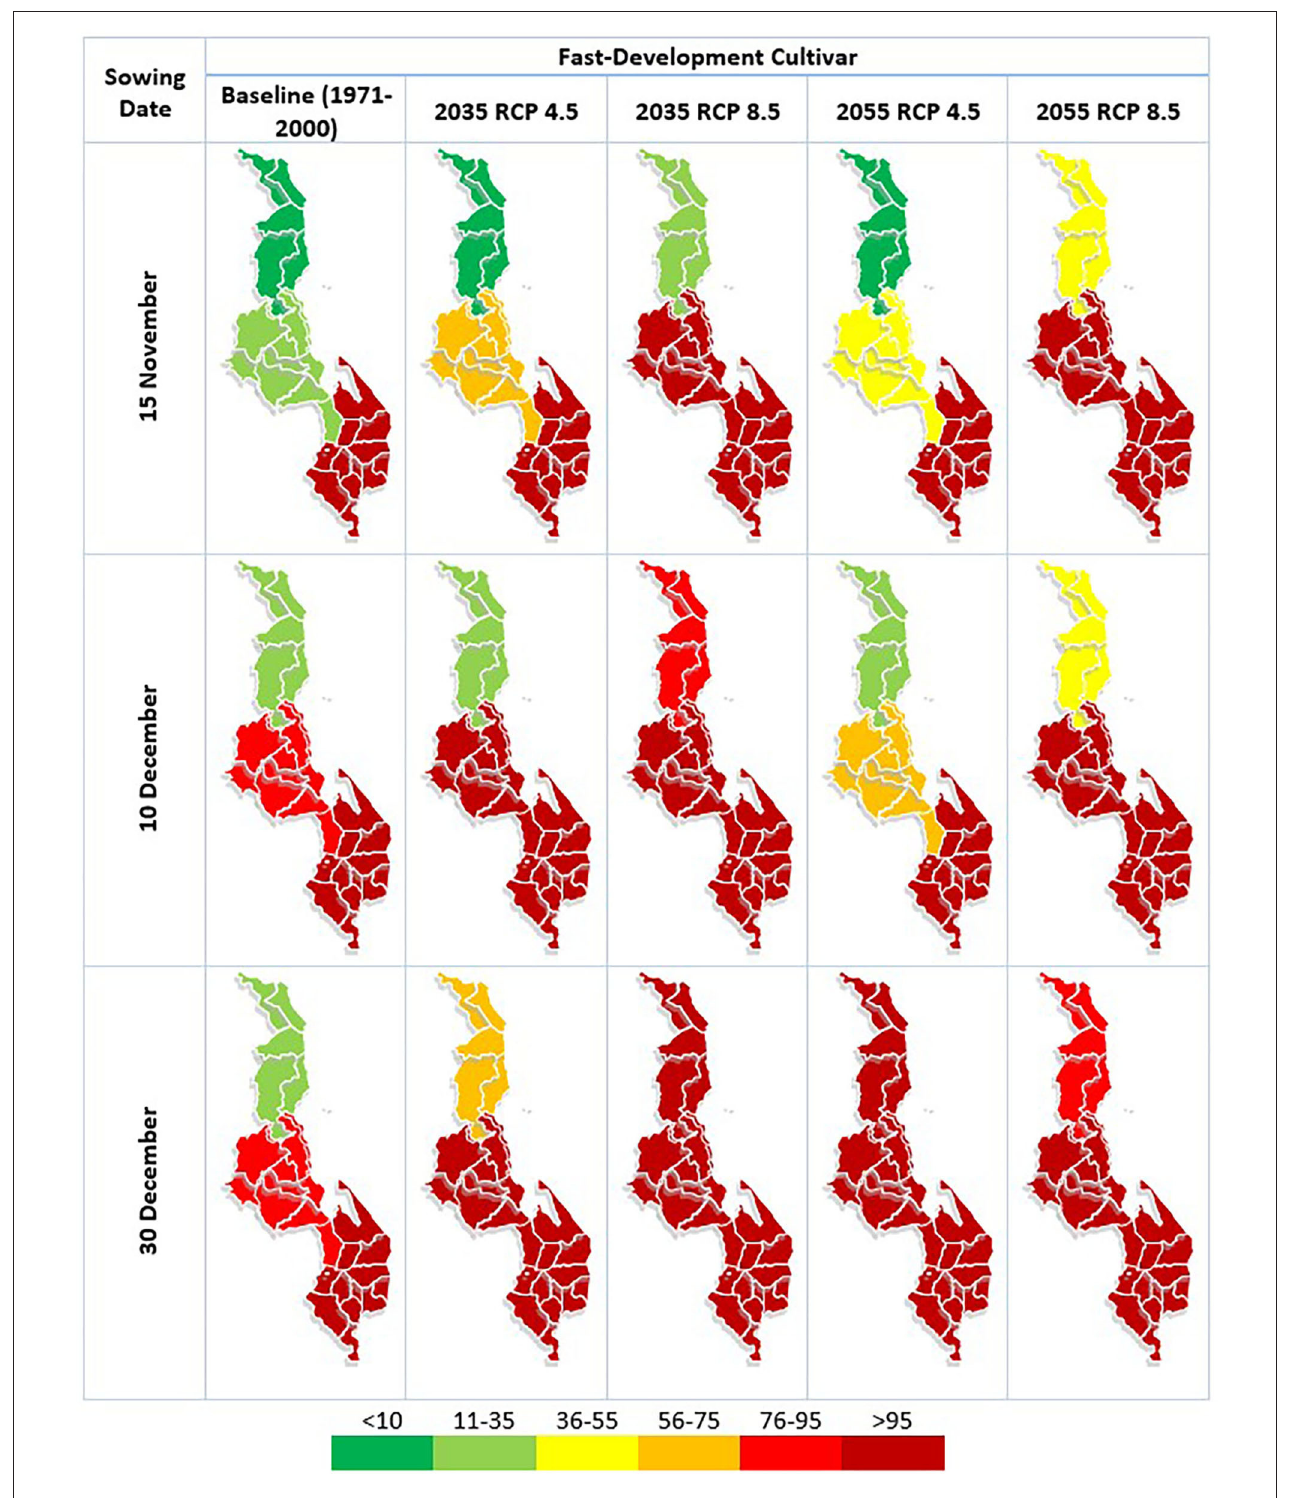
FIGURE 4 | AFI risk for fast-developing maize variety in each region of Malawi under differing climatic conditions and sowing dates. The first of the five rows represents the AFI risk under the baseline climate condition (1971–2000), the second and third row represent this risk associated with the 2020–2049 climate under RCP 4.5 and 8.5, respectively, and the final two rows represent this risk associated with the 2040–2069 climate under RCP 4.5 and 8.5, respectively. The three columns represent the different sowing dates assessed: 15 November, 10 December and 30th of December. The index at the bottom places the AFI results into color bands, with the deepest red indicating AFI levels which are consistent with exceedances of the EU threshold for AFB 1 contamination in food.